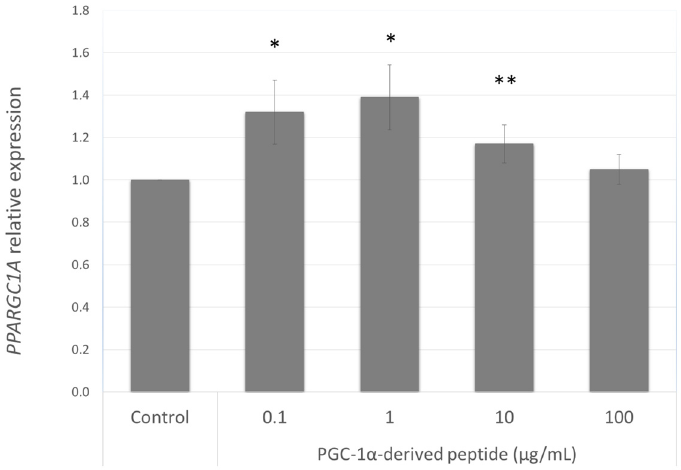
Figure 3. PPARGC1A gene expression in NHDF cells. NHDF cells were treated with the PGC-1 α - derived peptide at various concentrations for 24 h, then PPARGC1A gene expression was determined